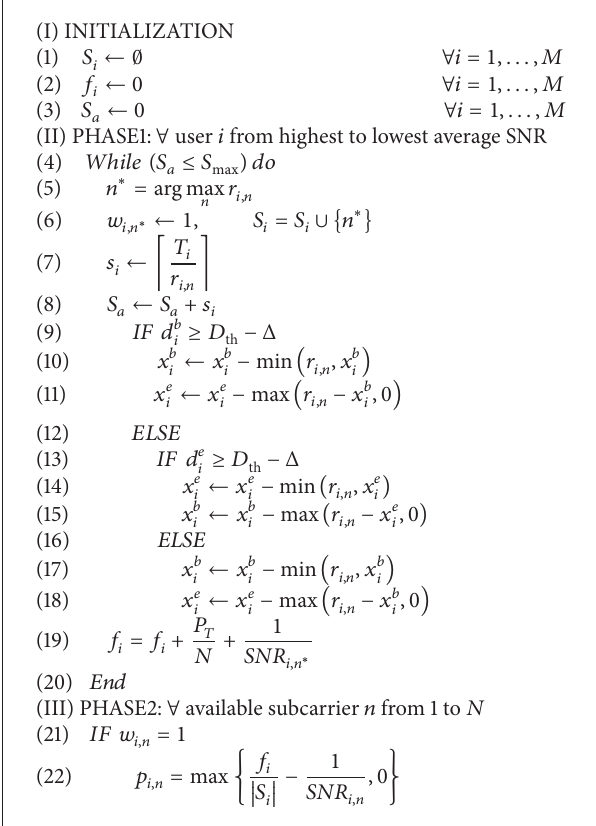
Algorithm 1: Heuristic